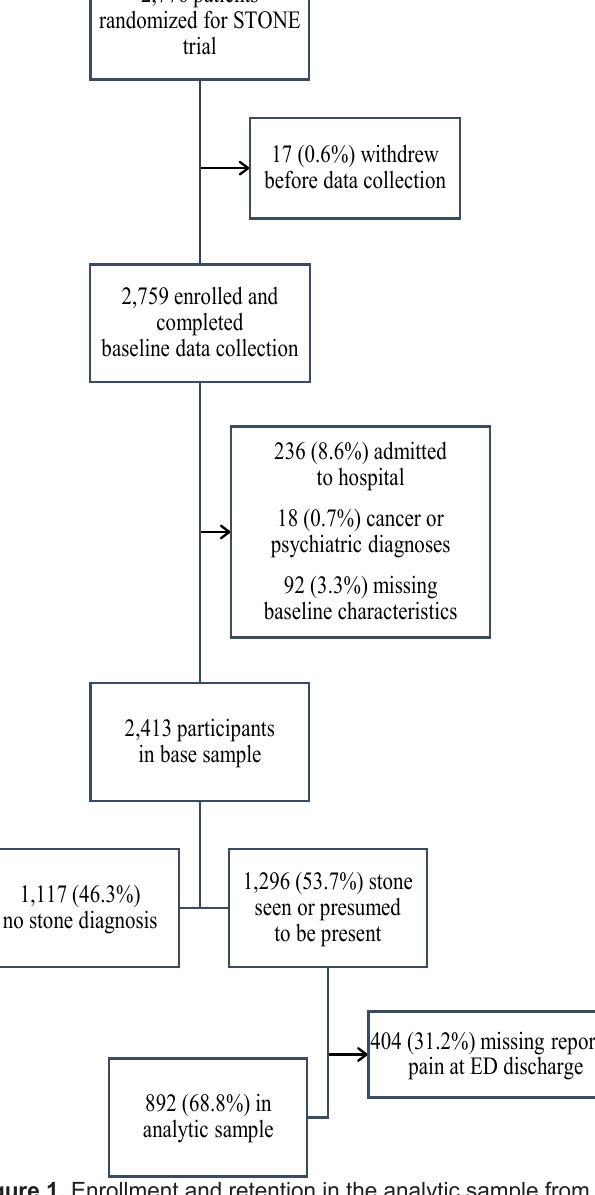
Figure 1. Enrollment and retention in the analytic sample from the STONE trial. STONE, Study of Tomography of Nephrolithiasis Evaluation; ED, emergency